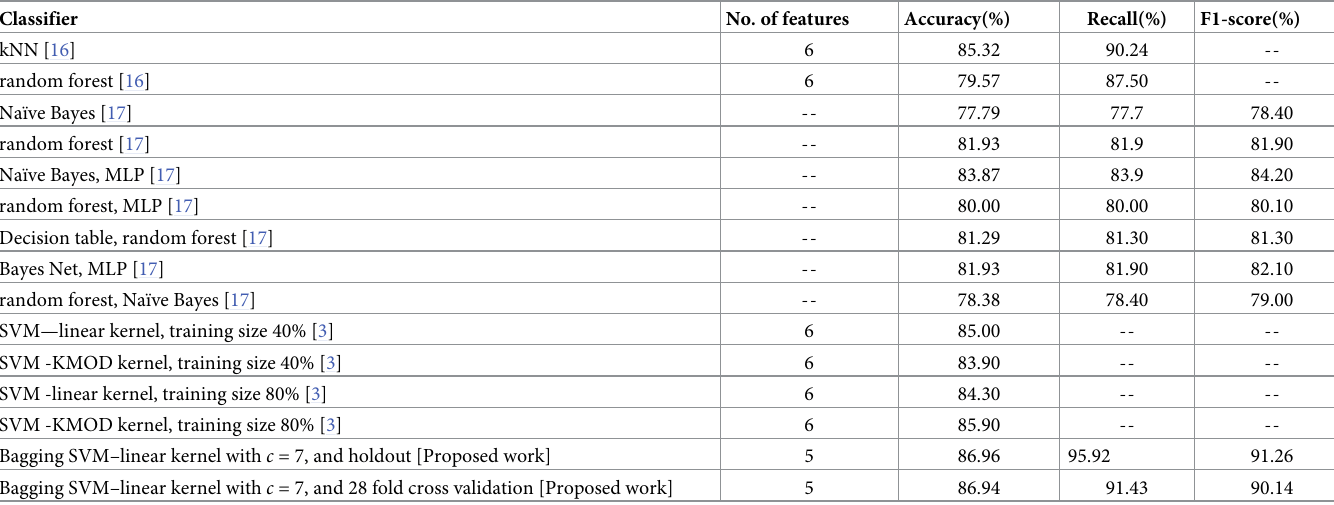
bagging SVM and bagging LR use only five features which are the ones used by SVM except for the cervical tilt feature. In order to obtain the best performance from SVM, the parameter c is varied for linear kernel, while the parameters c and γ are varied for RBF kernel. For the SVM algorithm, the linear kernel is shown to provide better training and testing accuracy than other kernels. Furthermore, for bagging SVM, the parameter c of linear kernel is varied to obtain the optimum value. The classifiers perform well when 22% of the spinal abnormality data are used for testing and the remaining 78% as training. Experimental results demonstrate that SVM with 6 features or LR with 5 features have an acceptable recall or detection rate of 91.84% and precision of 90%. The classification accuracies of selected features of spinal samples using SVM, LR, bagging SVM and bagging LR are 86.96%. Precision versus recall, and ROC curves